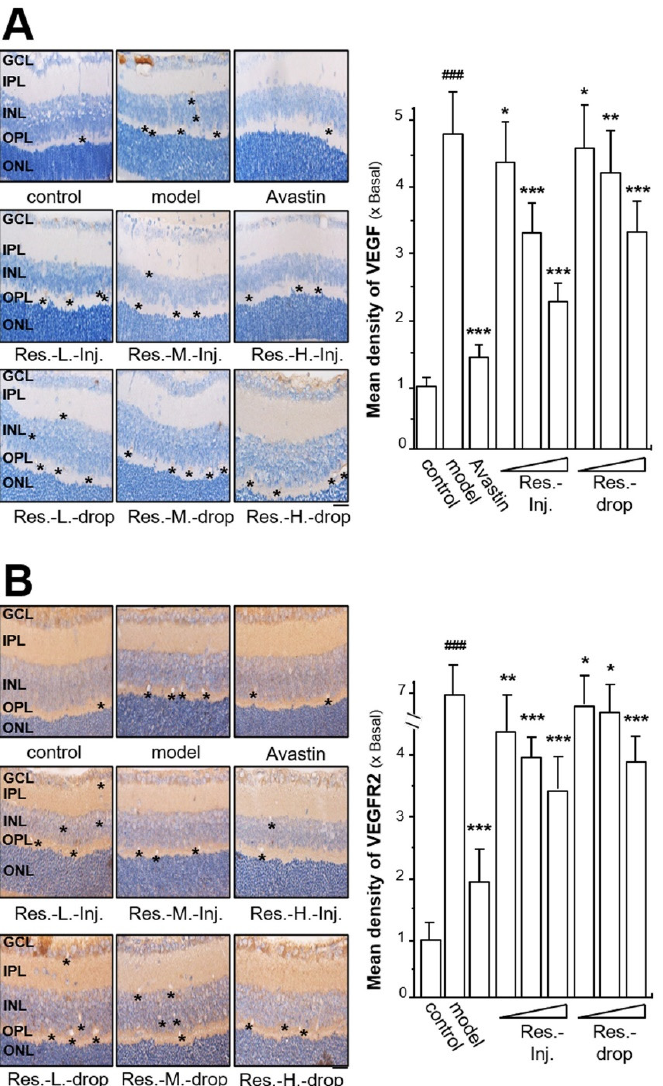
Figure 3. Resveratrol inhibits hyperoxia-induced expressions of VEGF and VEGFR2 in retinal ROP model. ( A ) Retinal tissues from drug-treated mice were collected, as in Figure 1. Tissues were immuno-stained with the VEGF antibody and stained by DAB dye. The positive area is brown or yellowish brown (left). * shows the expressed part of the target protein. Image-Pro Plus version 6.0 software was used for the quantification of VEGF density (right). ( B ) Retinal tissues were immuno- stained with the VEGFR2 antibody and stained by DAB dye. The positive area is brown or yellowish brown (left). * shows the expressed part of the target protein. Image-Pro Plus version 6.0 software was used for the quantification of VEGFR2 density (right). Results are expressed as the fold of change to the control (x basal), where the control group (no drug) was set as 1, Mean ± SEM, where n = 6; ### p < 0.001 vs. the control group; * p < 0.05; ** p < 0.01; *** p < 0.001 vs. the model group. Bar = 25 µ